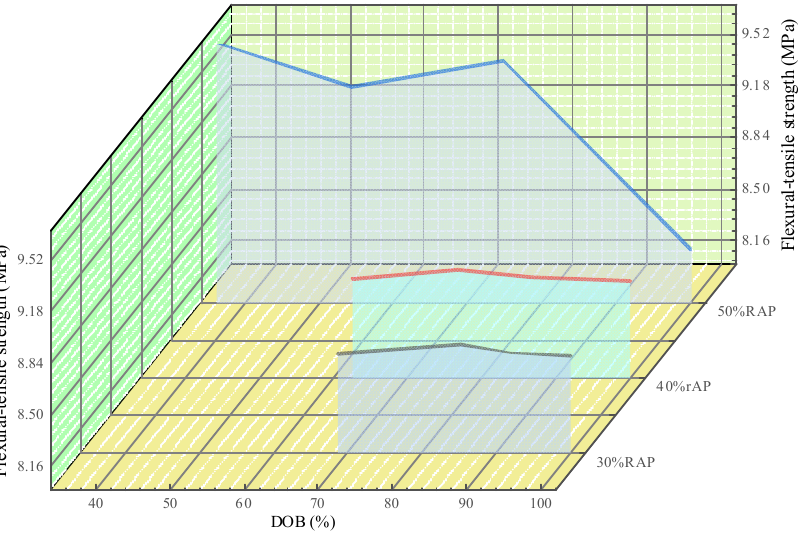
Figure 5. Variation of flexural–tensile strength with the variation of DOB under different RAP con-